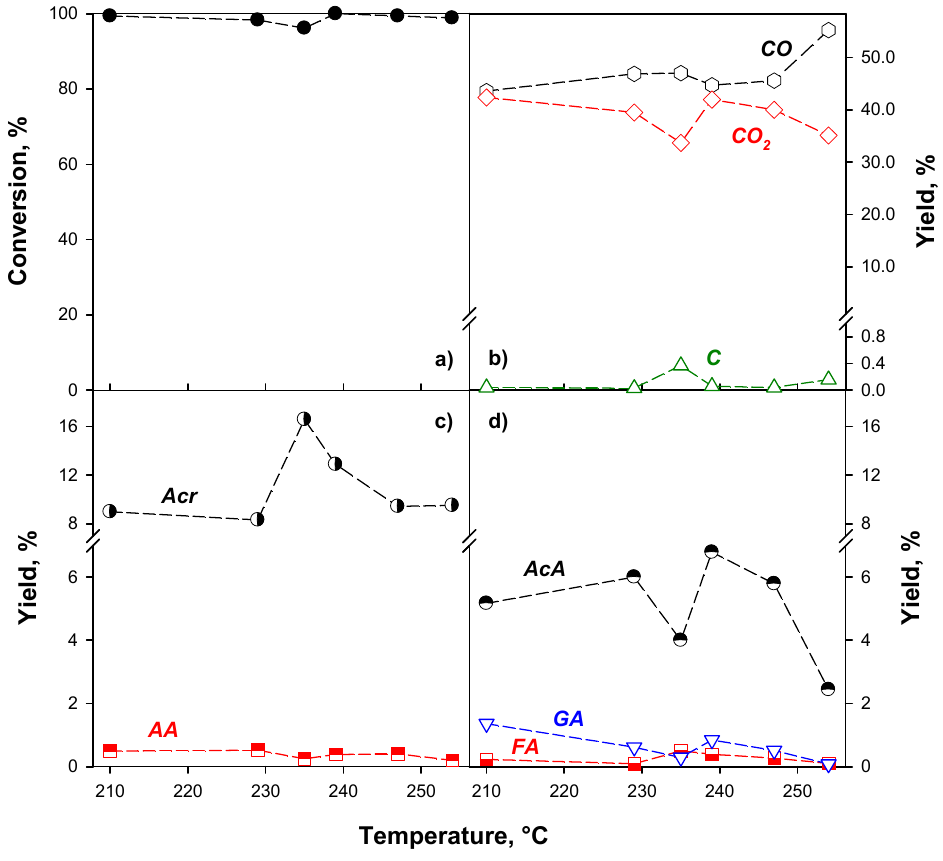
◇ Figure 5. ( a ) Glycerol conversion, ( b ) yields to CO ( ⬡ ), CO 2 ( ◇ ), and coke (C, △ ), ( c ) yields to acrolein Figure 5. ( a ) Glycerol conversion, ( b ) yields to CO ( ⬡ ), CO 2 ( ◇ ), and coke (C, △ ), ( c ) yields to acrolein Figure 6. ( a ) Glycerol conversion, ( b ) yields to CO ( ⬡ ), CO 2 ( ◇ ), and coke (C, △ ), ( c ) yields to acrolein Figure 5. ( a ) Glycerol conversion, ( b ) yields to CO ( ), CO 2 ( (cid:94) ), and coke (C, (cid:52) ), ( c ) yields Figure 5. ( a ) Glycerol conversion, ( b ) yields to CO ( ⬡ ), CO 2 ( ), and coke (C, △ ), ( c ) yields to acrolein (cid:57) Figure 5. ( a ) Glycerol conversion, ( b ) yields to CO ( ⬡ ), CO (Acr, ◑ ) and acrylic acid (AA,  ⬒ ), ( d ) yields to acetic acid (AcA, ◓ ), formic acid (FA, ⬓ ), and glycolic (Acr, ◑ ) and acrylic acid (AA,  ⬒ ), ( d ) yields to acetic acid (AcA, ◓ ), formic acid (FA, ⬓ ), and glycolic to acrolein (Acr, (Acr, ◑ ) and acrylic acid (AA,  ⬒ ), ( d ) yields to acetic acid (AcA, ◓ ), formic acid (FA, ⬓ ), and glycolic 2 ( ◇ ), and coke (C, △ ), ( c ) yields to acrolein ▽ (Acr, ◑ ) and acrylic acid (AA, ( ⬒ ), ( d ) yields to acetic acid (AcA, ◑ ), formic acid (FA, ⬓ ), and glycolic (Acr, ◑ ) and acrylic acid (AA,  ⬒ ), ( d ) yields to acetic acid (AcA, ◓ ), formic acid (FA, ⬓ ), and glycolic acid (GA, ▽ ) as a function of the temperature on VOP/Ti; τ = 0.057 g∙s∙cm − 3 , Gly/H 2 O/O 2 /N 2 = 2/41/6/51 ), and glycolic acid (GA, (cid:53) ) as a function of the temperature on VOP / Ti; τ = 0.057 g · s · cm − 3 , acid (GA,  ) as a function of the contact time on VOP/Ti; temperature = 230 °C, Gly/H 2 O/O 2 /N 2 = acid (GA, ▽ ) as a function of the temperature on VOP/Ti; τ = 0.057 g∙s∙cm − 3 , Gly/H 2 O/O 2 /N 2 = 2/41/6/51 ) as a function of the temperature on VOP/Ti; τ = 0.057 g·s·cm − 3 , Gly/H 2 O/O 2 /N 2 = 2/41/6/51 acid (GA, acid (GA, ▽ ) as a function of the temperature on VOP/Ti; τ = 0.057 g∙s∙cm − 3 , Gly/H 2 O/O 2 /N 2 = 2/41/6/51 Gly / H 2 O / O 2 / N 2 = 2 / 41 / 6 / 51 vol. vol. %. 2/41/6/51 vol. %. vol. %. vol. %. vol. %.